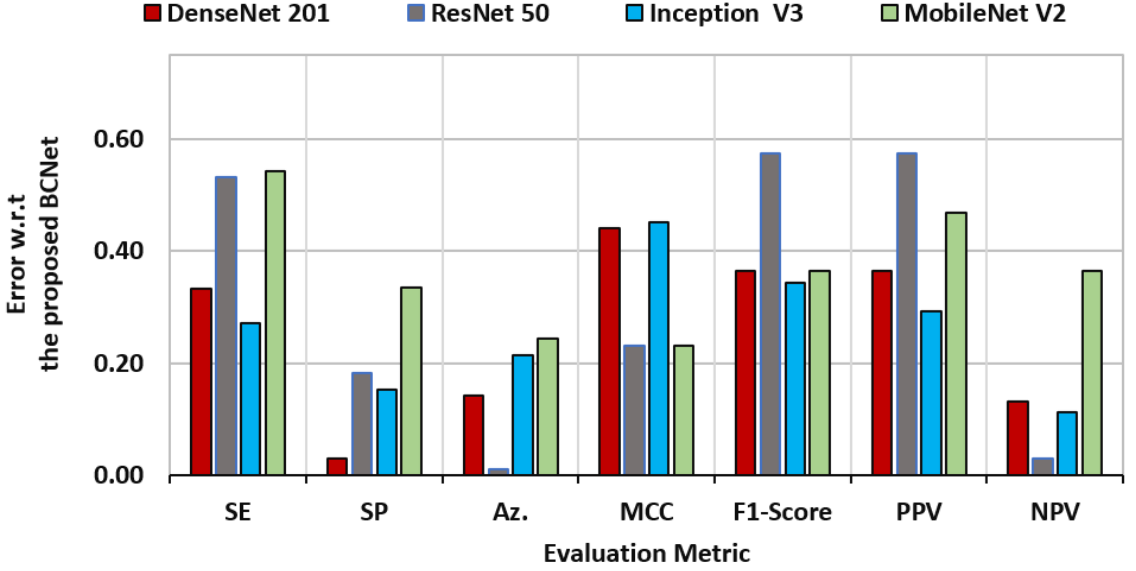
Figure 8. Evaluation error performance of the latest deep learning models of DenseNet 201, ResNet 50, Inception V3, and Mobile Net V2 with respect of the proposed BCNet model.